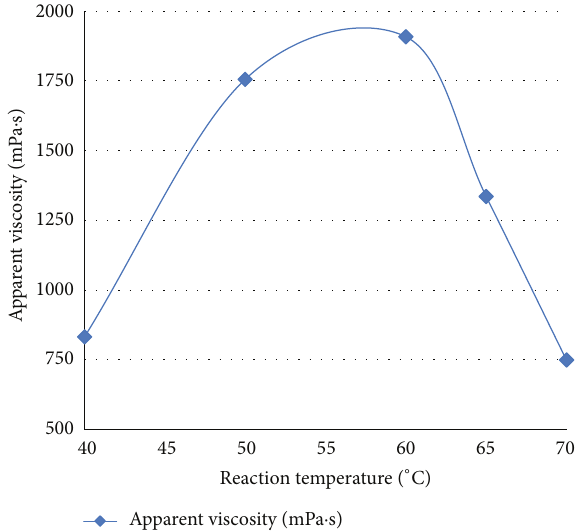
Figure 8: Effect of reaction temperature on apparent viscosity.